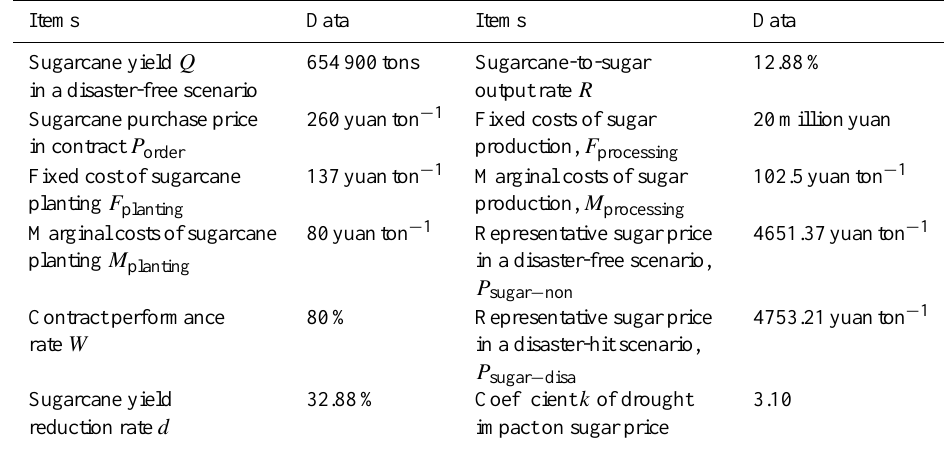
Table 4. Background data (2009–2010) of Yuanjiang sugar industry in Yunnan.